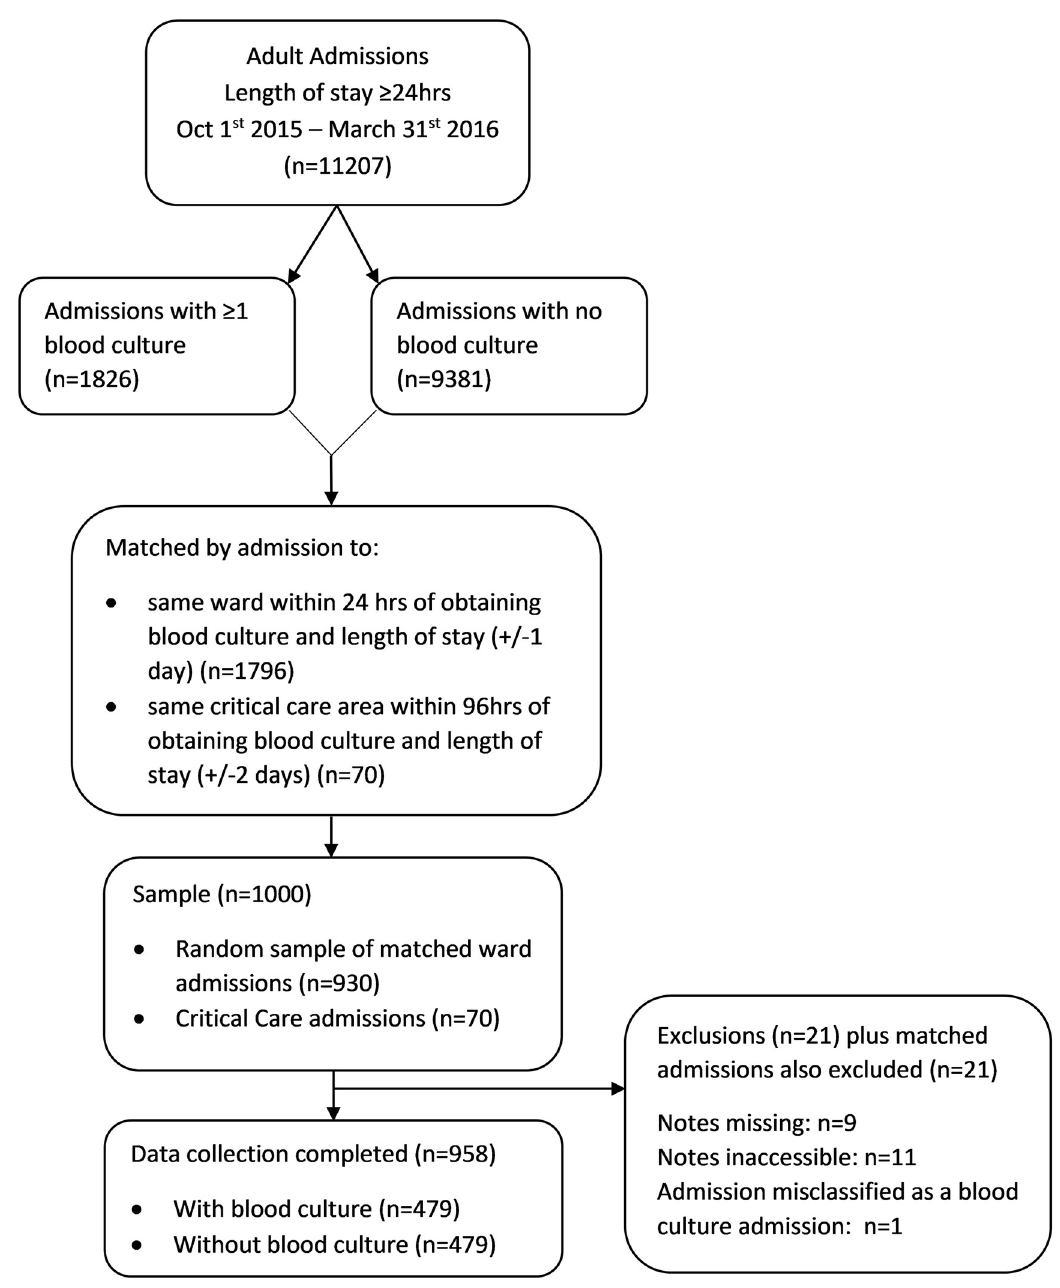
Fig 1. Cohort selection flow